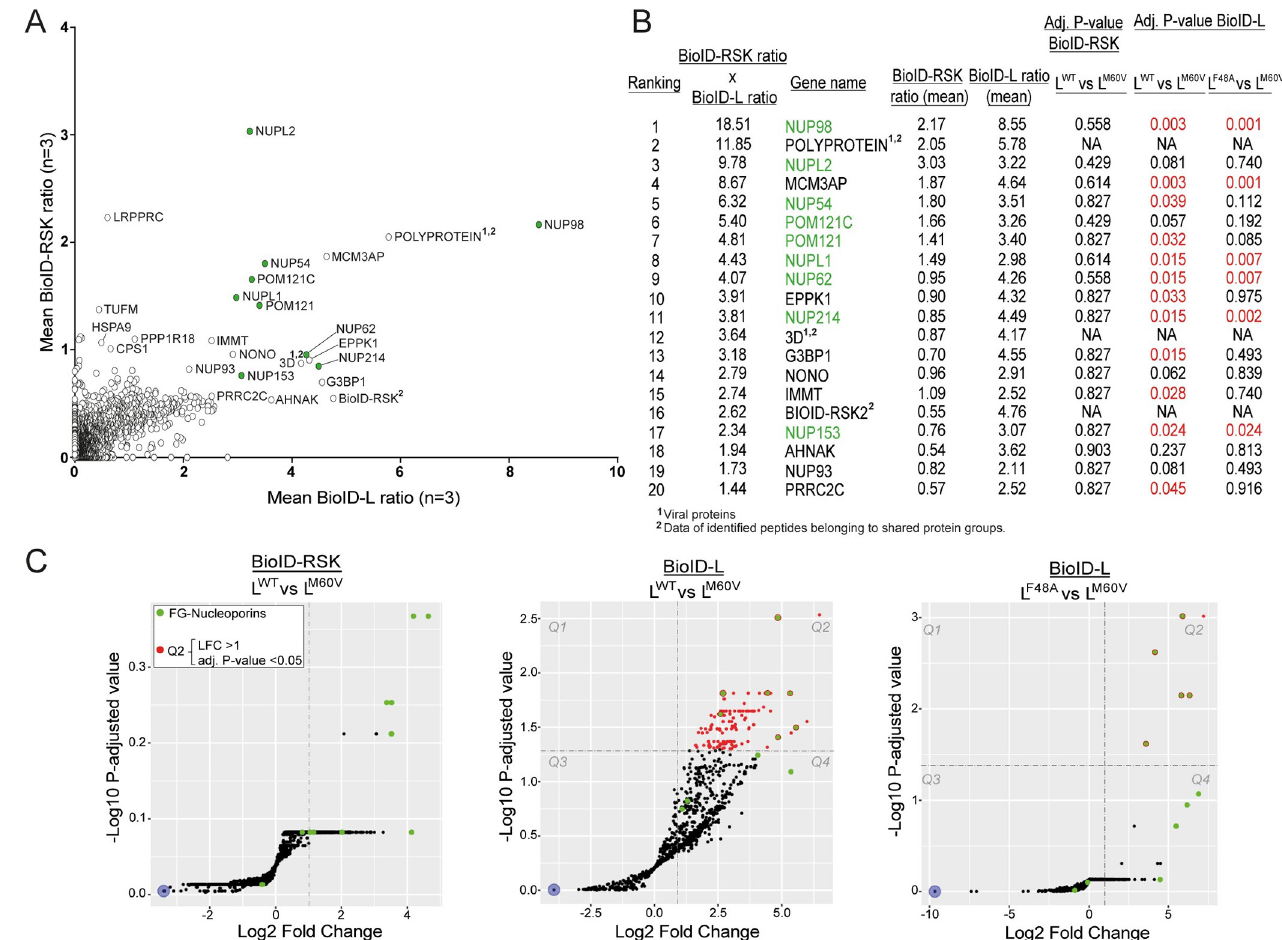
Fig 6. BioID-RSK and BioID-L proxeomes identify FG-NUPs as targets recruited by the L-RSK complex. (A) Proteins identified in the proximity of BioID-RSK (Y axis) and BioID-L (X axis). Y axis shows proteins detected after infection with L WT but not L M60V viruses and in non-infected conditions (= PSMs in L WT /(L M60V +NI+1)). X axis shows proteins detected after infection with BioID-L WT and BioID-L F48A but not BioID-L M60V replicons and in non- infected conditions (= PSMs in (L WT + L F48A) /(L M60V +NI+1)). FG-NUPs are identified by green dots. (B) Table showing the adjusted P-values for the 20 best ranked proteins. Ranking was attributed by multiplying the BioID-RSK ratio by the BioID-L ratio. Statistical analysis of pairwise comparisons made between L WT and L M60V for BioID-RSK and between L WT and L M60V or L F48A and L M60V for BioID-L. Adjusted P-values < 0.05 are colored in red, FG-NUPs are colored in green. (C) Volcano plots showing the same pairwise comparisons as in B. Proteins having an adjusted P-value < 0.05 and a Log 2 fold change (LFC) > 1 are colored in red (= proteins in Q2). FG-NUPs are colored in green.